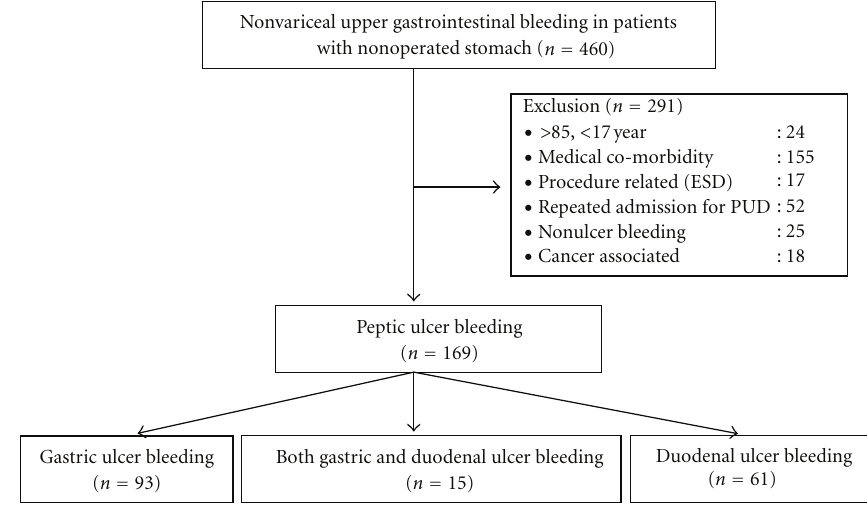
Figure 2: Study enrollment of the peptic ulcer bleeding with nonoperated